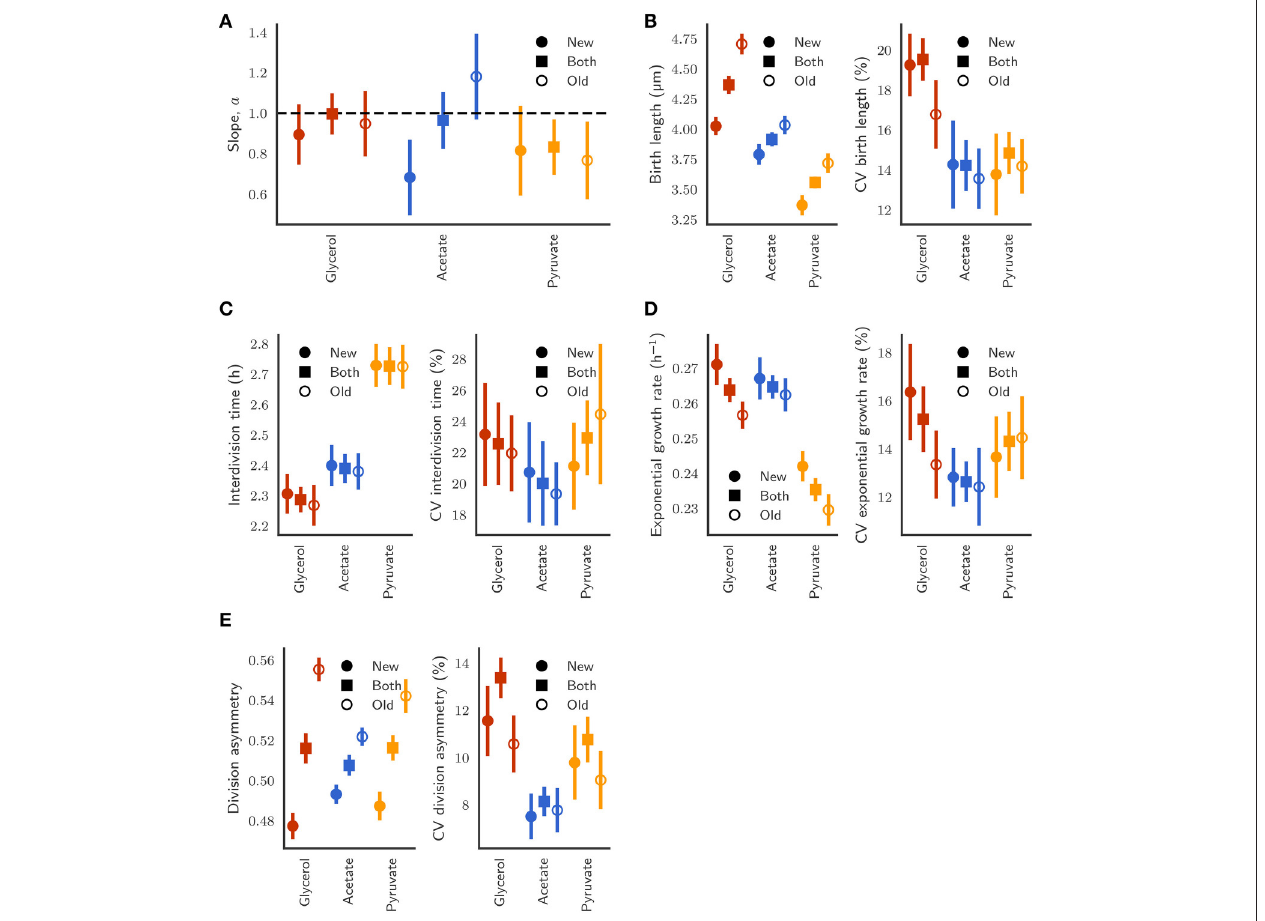
FIGURE 7 | (A) Comparison of the slope of the linear relationship between initial length and final length between new-pole (closed circles), old-pole (open circles), and both pole (closed squares) daughter cells. Error bars depict bootstrapped 95% confidence intervals. (B) Birth length and coefficient of variation (CV) of the distributions. (C) Interdivision time and CV. (D) Exponential growth rate and CV. (E) Division asymmetry and CV, where asymmetry is defined as the ratio of birth length to the sum of birth lengths of both